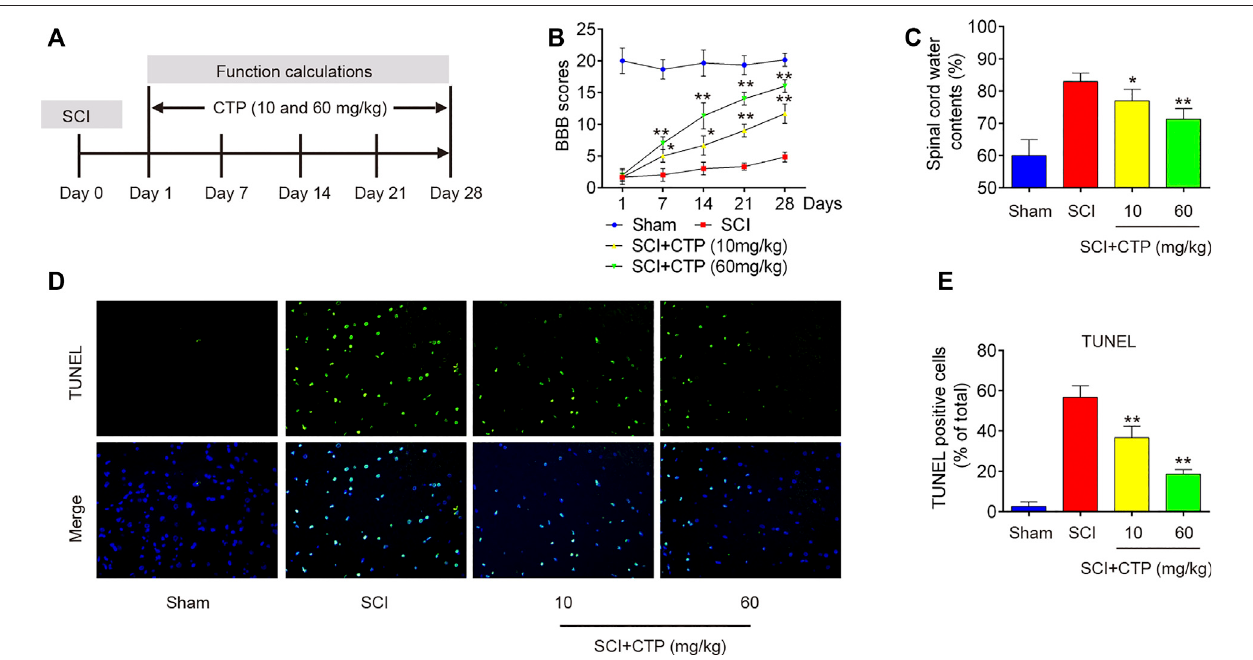
FIGURE1| CatalpolimprovesrecoveryofSCIoperatedmicebyreducingapoptosis.AfterSCImicemodelwasestablished,CTP(10and60 mg/kg)wassubjected to SCI mice once a day for 28 days. (A) SCI mice model and Catalpol treatment protocol. (B) Changes in BBB scores ofSCI mice treated with or without Catalpol at the indicated days. (C) Water content in spinal cord of mice was detected. (D – E) TUNEL staining of neuronal apoptosis of spinal cord tissues post-Catalpol treatment at 28 days. Data represent the mean ± SD of three independent experiments. * p < 0.05, ** p < 0.01 vs. SCI group.